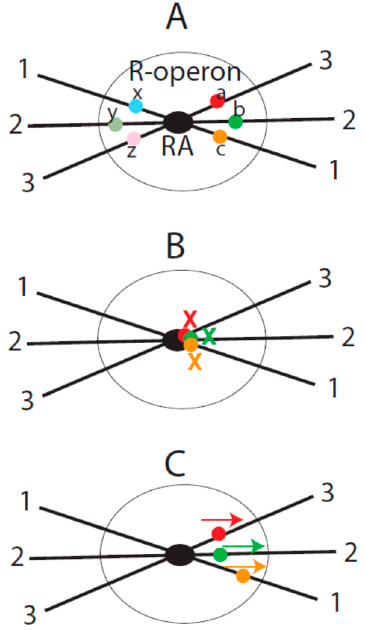
Figure 1. Coordination of gene expression by the R-operon. ( A ) Conceptual illustration of R-operon. Shown is an R-operon consisting of a repeat assembly (RA) from three genomic loci (indicated by 1, 2 and 3) and the associated genes (colored dots) proximal to the RA (black dots); ( B ) Co-repression in the R-operon. When genes are closely associated with the RA, their transcriptional activity can be suppressed (see text); ( C ) Co-activation in the R-operon. Genes proximal to the RA may be co-activated by trans-activation or chromatin contacts facilitated by the RA (see text).